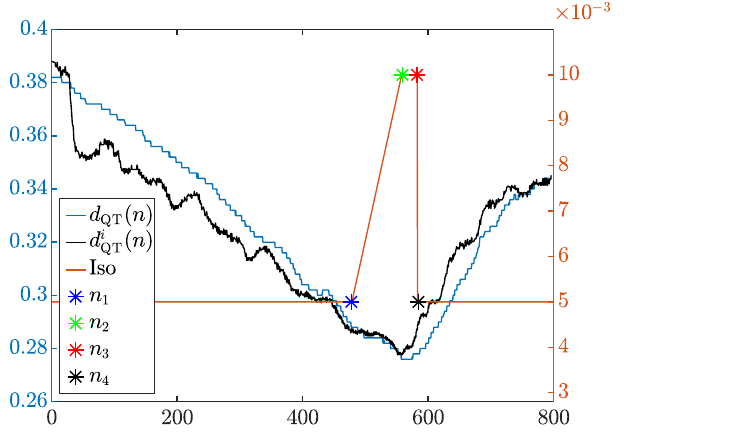
Fig 3. Time-varying pattern of Iso concentration during exercise and recovery, with time points n 1 , n 2 , n 3 and n 4 determined from the d i ð n Þ and d QT ( n ) time series of an analyzed ECG recording from a CAD patient. QT